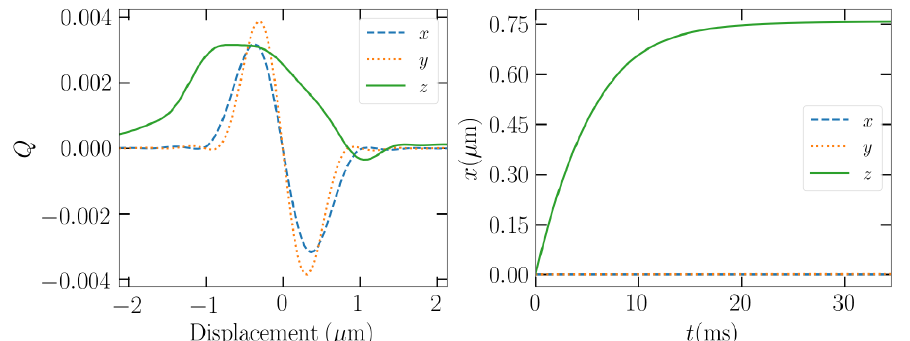
Fig 3. Left: Rotationally averaged linearly polarized LG 00 trap efficiency components for a 0.2 μ m cube spinning about its principal axis, which is parallel to the beam propagation direction + z . Right: Position as a function of time when suspended in air by the optical